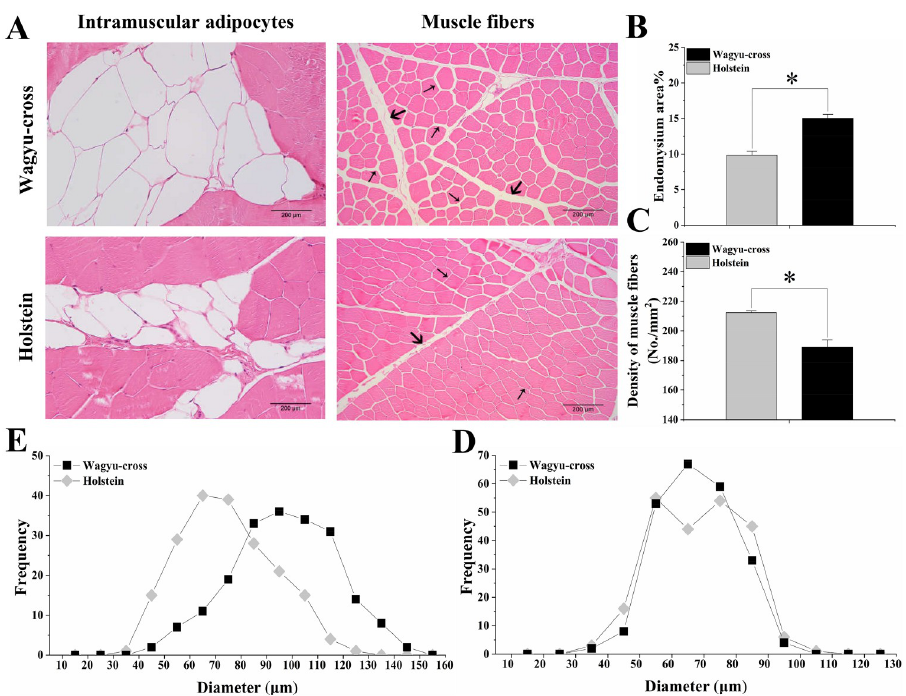
Fig 1. Histological analysis of muscle cross-sections in Wagyu-cross and Holstein steers. (A) HE staining of intramuscular adipocytes and muscle fibers. Scale bar: 200 μ m. Large arrows indicate perimysium, and small arrows indicate endomysium. (B) Endomysium area %. (C) Density of muscle fibers. (D) Frequency distribution of muscle fiber diameter. (E) Frequency distribution of intramuscular adipocyte diameter.